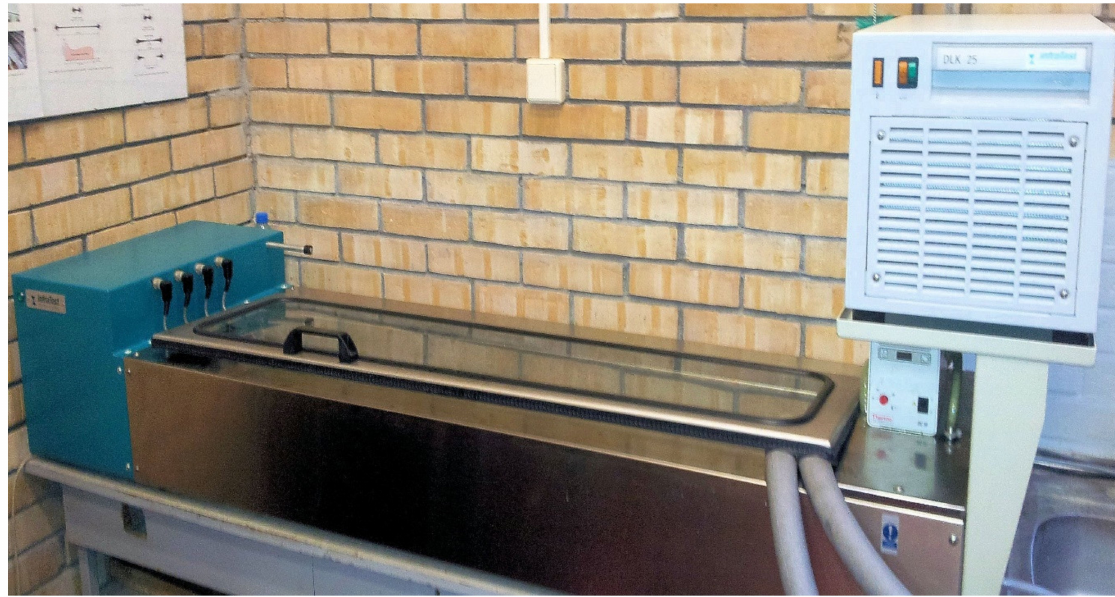
Figure 1. Ductilometer with an auxiliary cooling unit.